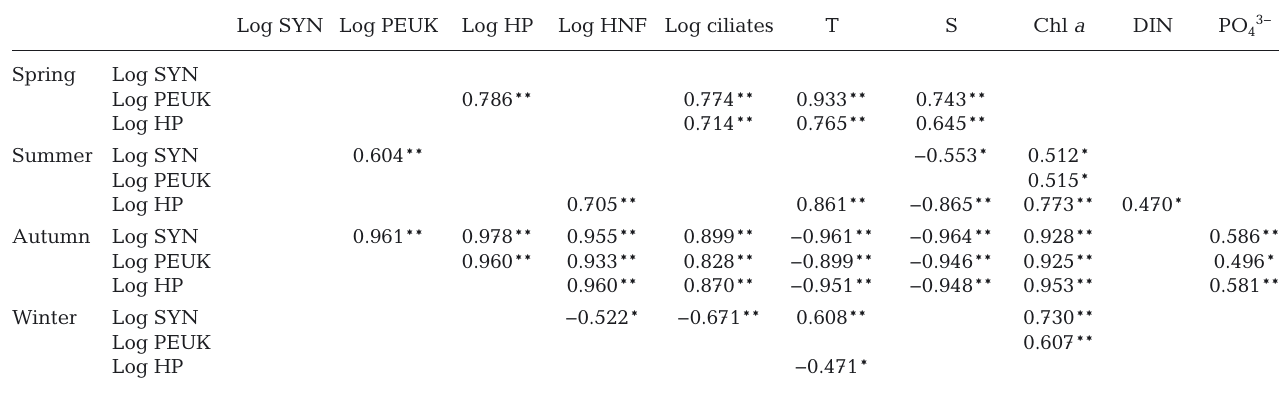
2. Spearman’s rank correlation coefficient between biological factors and picoplankton abundances in Sanggou Bay over 4 succes- sive seasons (all n = 19). SYN: Synechococcus ; PEUK: picoeukaryotes; HP: heterotrophic prokaryotes; HNF: heterotrophic